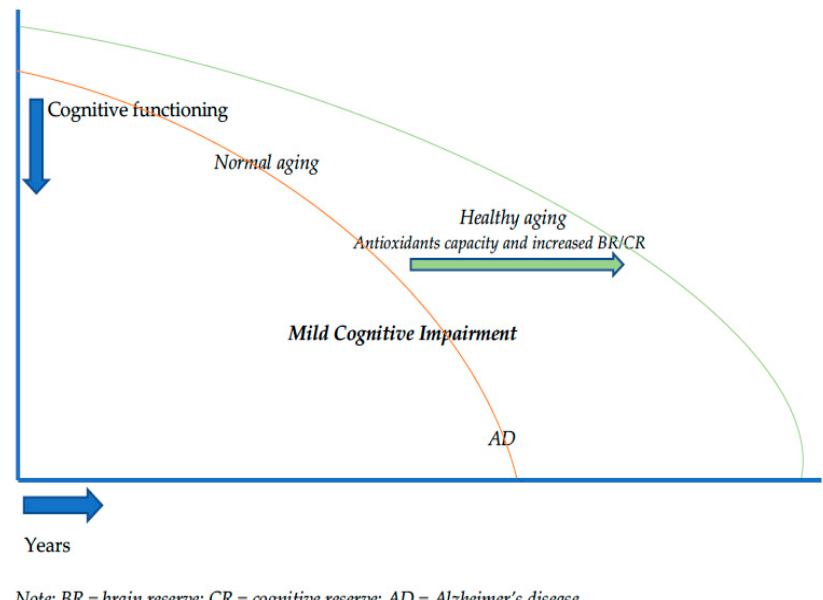
Figure 2. Trajectory of cognitive decline and resilience mechanisms.